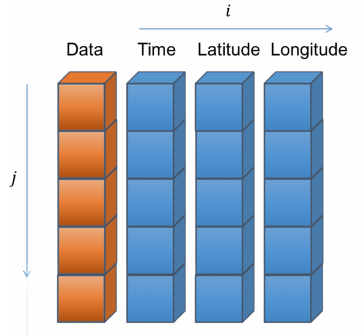
Figure A2. A list of data. Such a list is the primary data format used for both observations and model data in this paper. Reproduced from Watson-Parris et al.